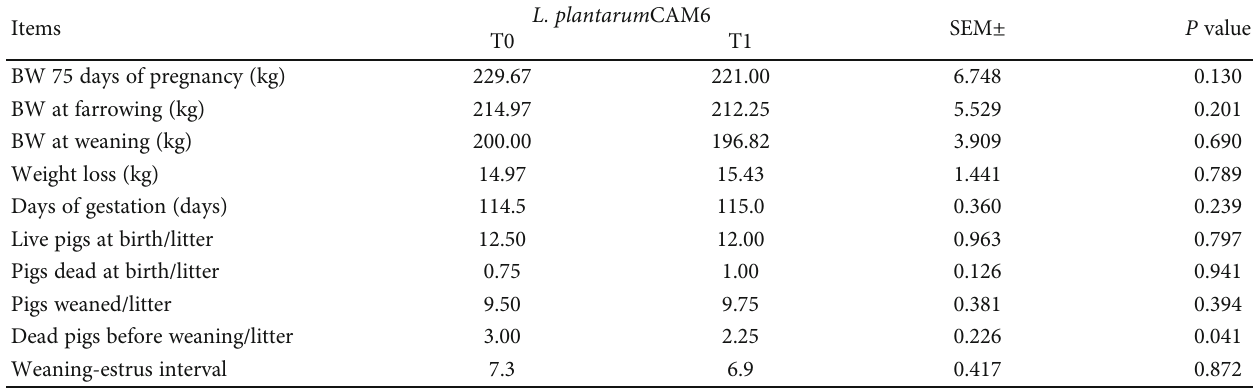
Table 2: E ff ect of oral supplementation of Lactobacillus plantarum CAM6 on lactating sows.